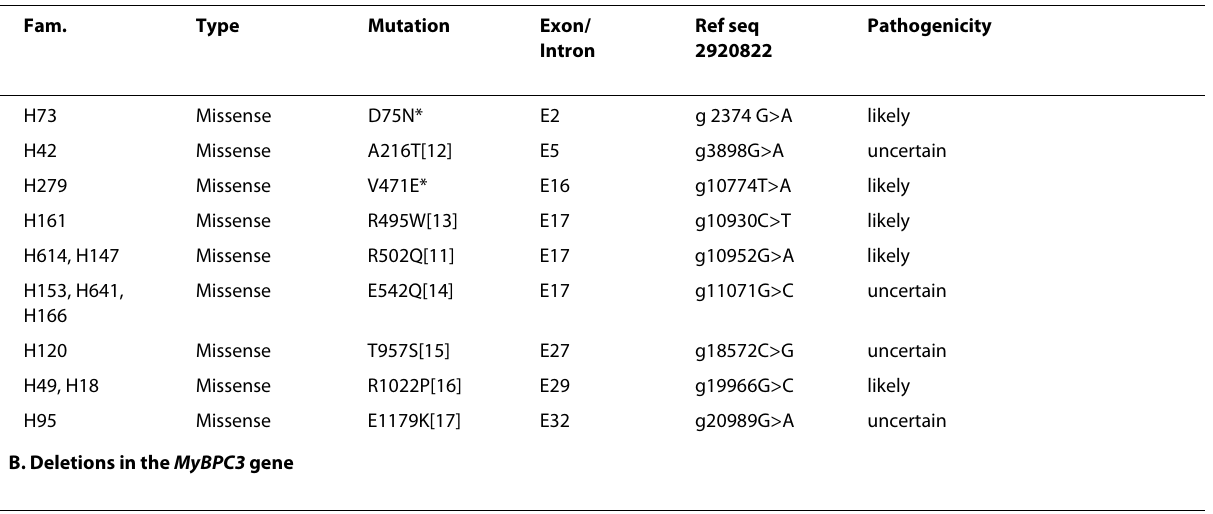
Table 1: Mutations in MyBPC3